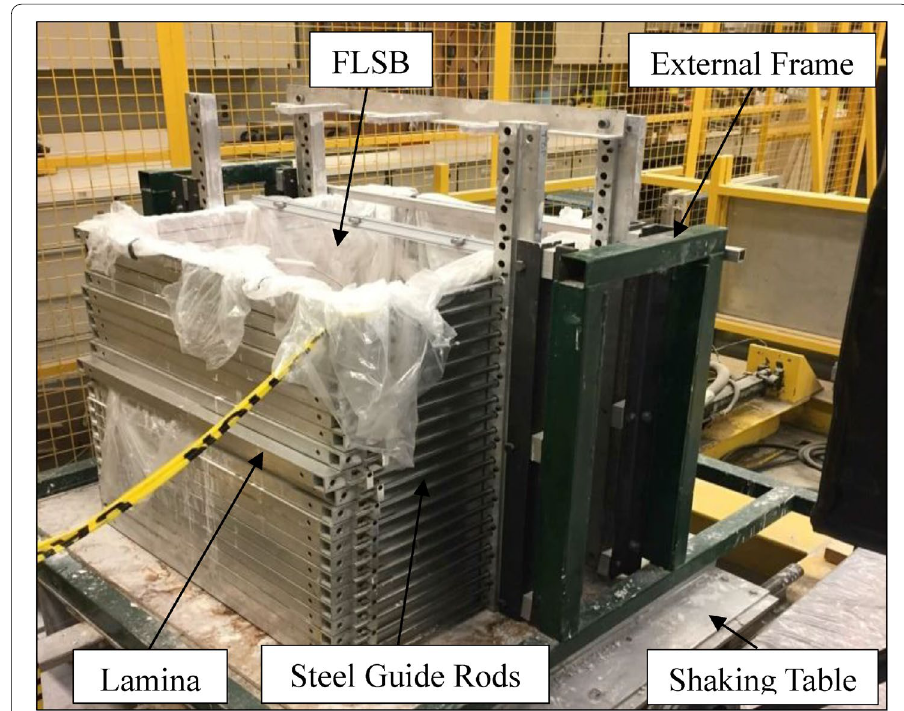
Fig. 3 Snapshot of the University of Ottawa FLSB (designed by